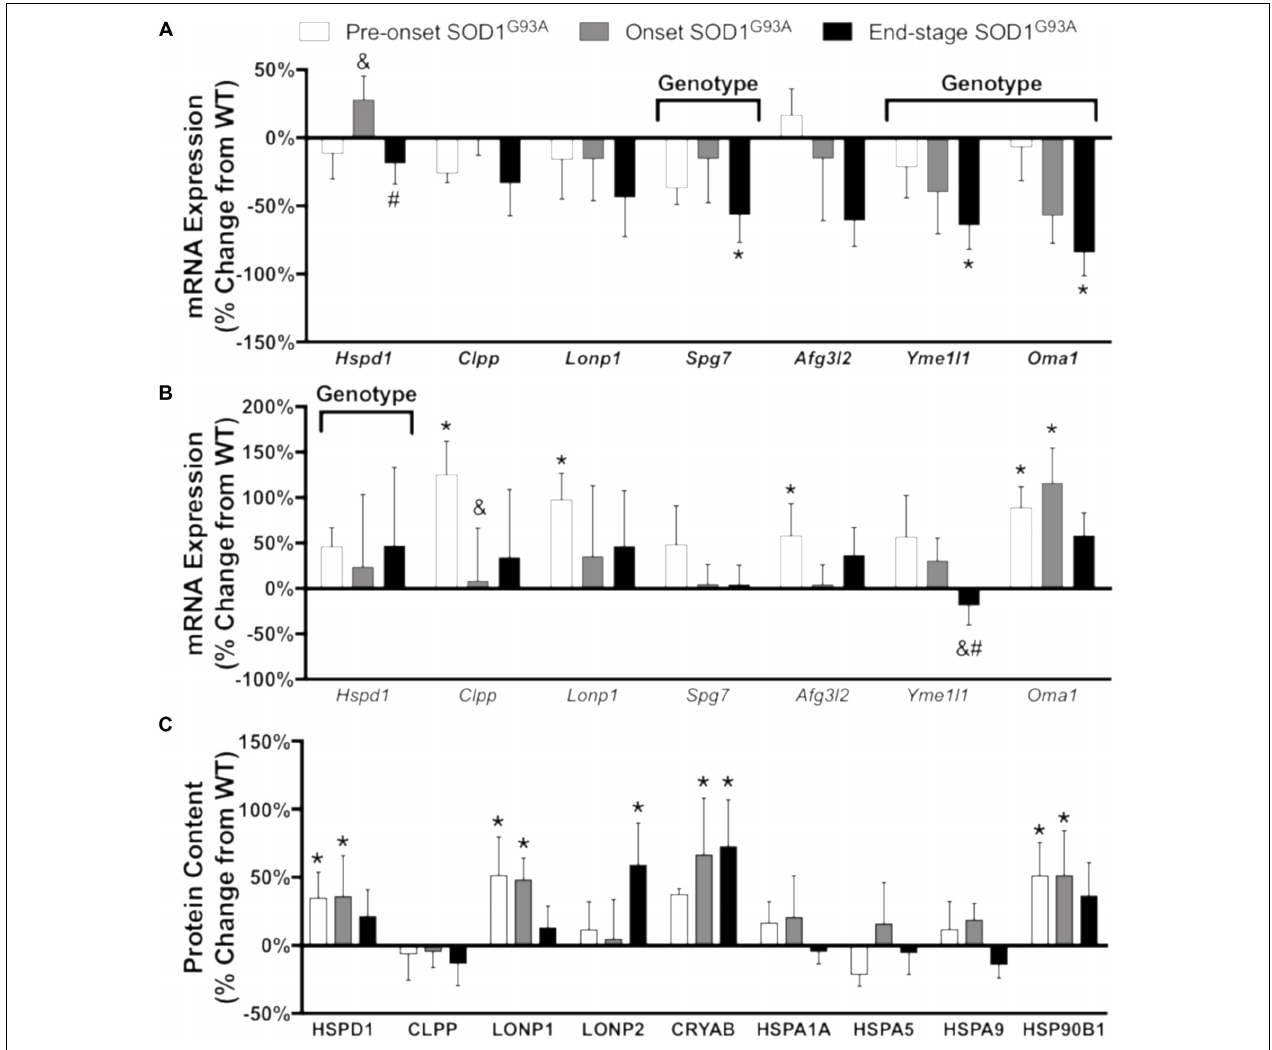
FIGURE 6 | Chaperones and proteases. Changes in mRNA expression and protein content of chaperones and proteases in SOD1 G93A gastrocnemius muscle and spinal cords compared to wild-type controls measured by RT-PCR and mass spectrometry ( n = 5–6). (A) mRNA expression in the gastrocnemius muscle. (B) mRNA expression in the spinal cord. (C) Protein content in the spinal cord. Data are represented as percent change relative to the same time point wild-type control. Bars represent means ± standard deviation. “Genotype” denotes a significant genotype effect in Benjamini-Hochberg corrected two-way ANOVA with p < 0.05 but no individual Multiple Comparison test was significant. Significance symbols demonstrate p < 0.05 for a genotype effect and additional significant results for the Tukey Multiple Comparison test. ∗ p < 0.05 wild-type vs. SOD1 G93A at the designated time point; & p < 0.05 vs. SOD1 G 93 A pre-onset; # p < 0.05 vs. SOD1 G93A onset. SOD1 G93A pre-onset (white), SOD1 G93A onset (gray), SOD1 G93A end-stage (black). Gene IDs and relative expression (RQ) values are detailed in Supplemental Tables 3 (spinal cord) and 4 (gastrocnemius). Protein names, IDs, and absolute expression values are detailed in Supplemental Table 1